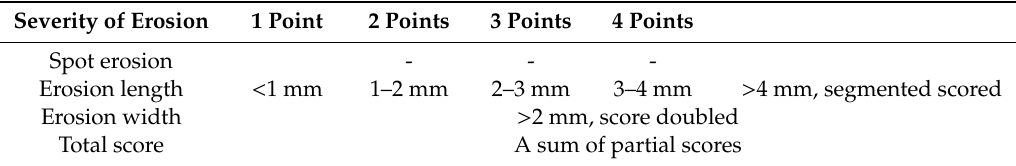
Table 1. The scoring criteria of gastric ulcer index